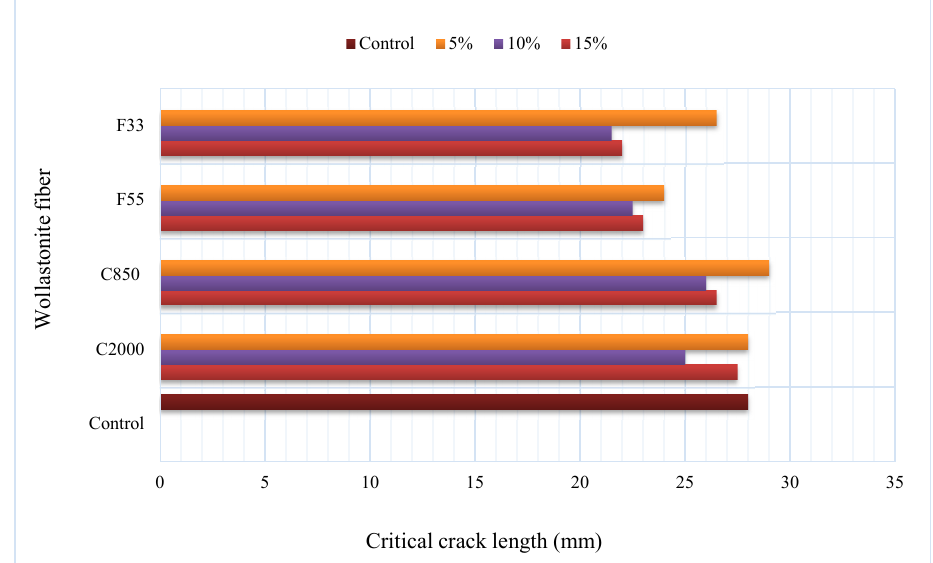
Figure 3. ( a ) Compressive and ( b ) flexural strengths of natural wollastonite and synthetic wollastonite based on Refs. [13,35].